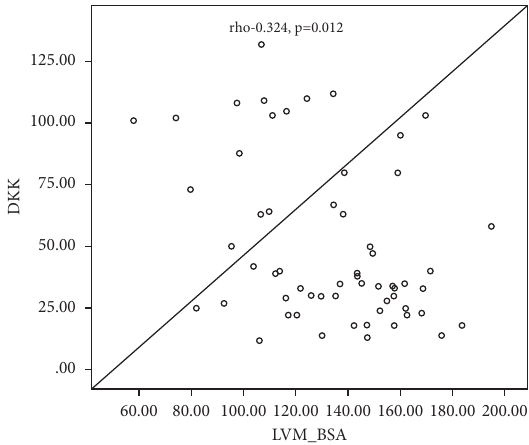
Figure 4: Linear negative correlation between the left ventricular mass index and serum Dickkopf-related protein-1.